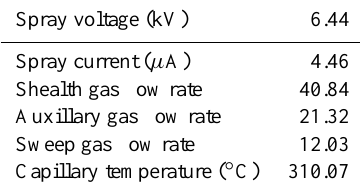
Table 1. Instrumental